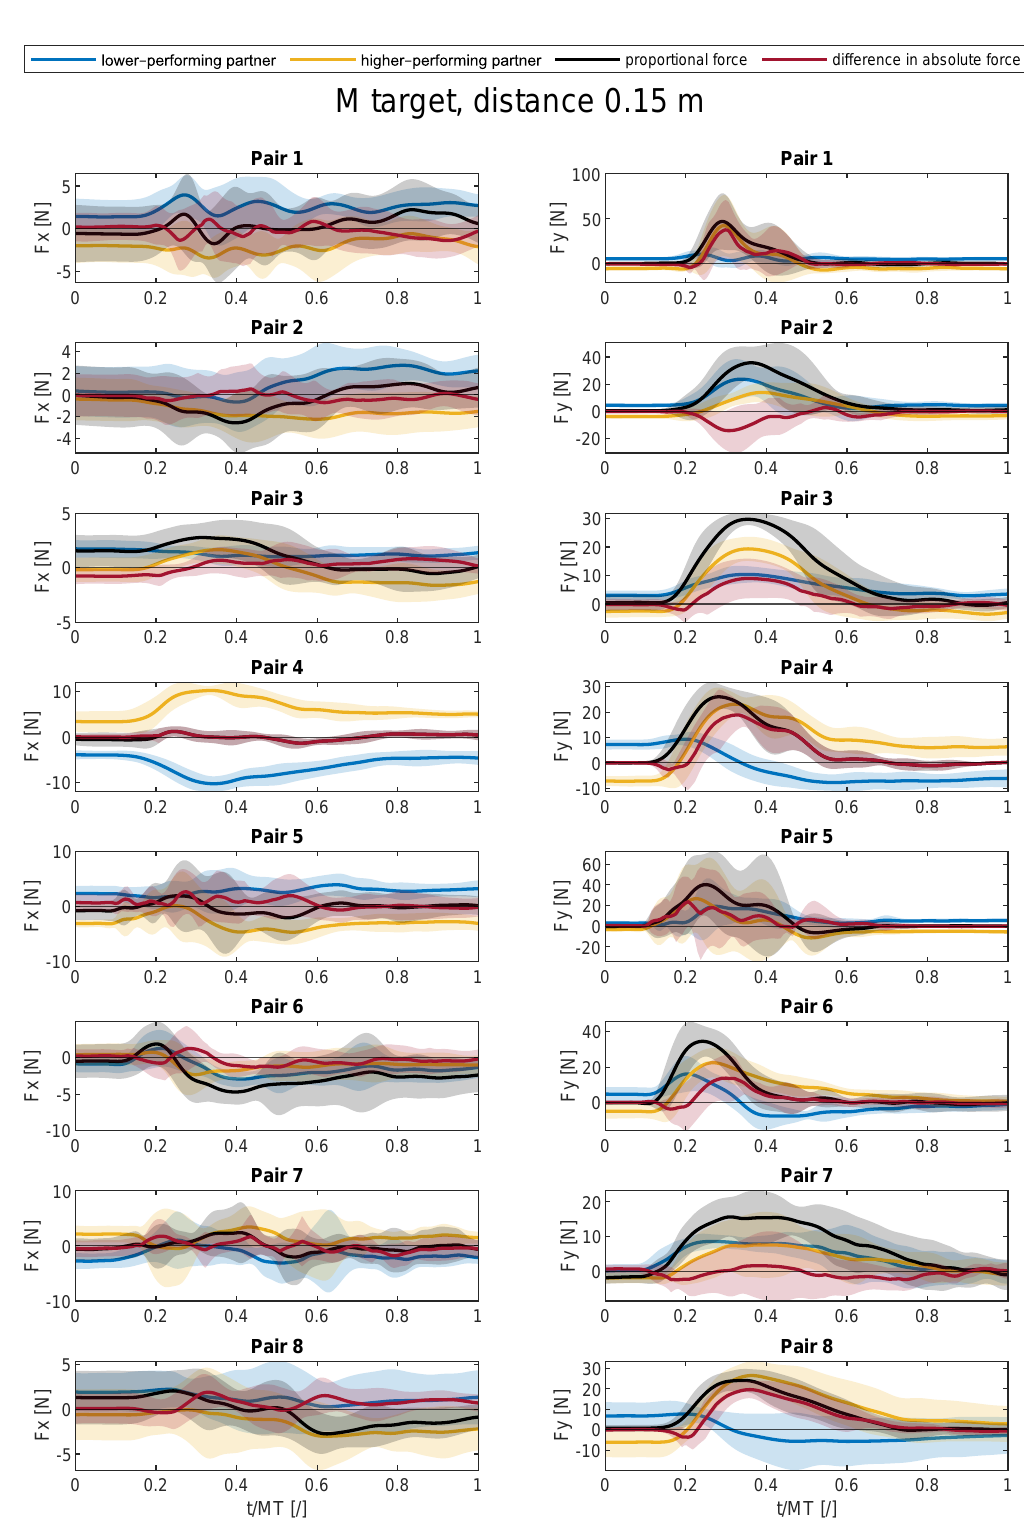
Figure A5. Average force trajectories with standard deviation (shaded area) in x- and y-direction in collaborative task for the medium target at the distance of 0.15